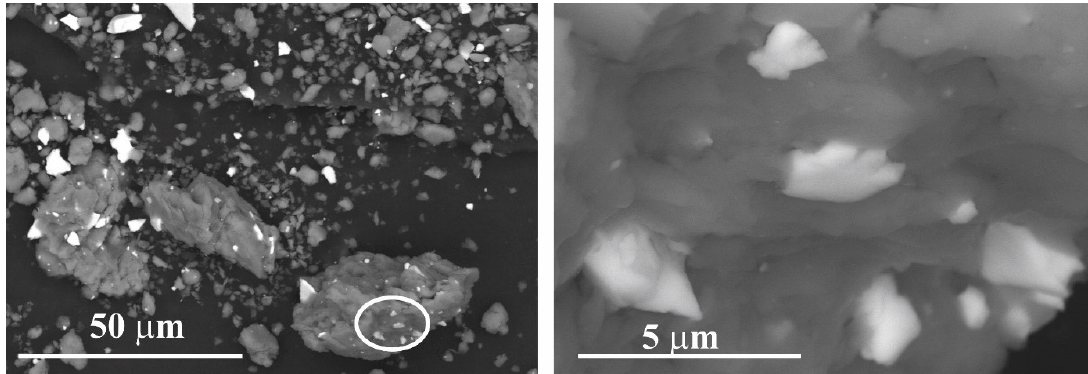
Figure 10. Backscattered SEM images of the composite material after 30 h milling time using ethanol as PCA ( a ) and magnified image of the area marked by the circle ( b ).